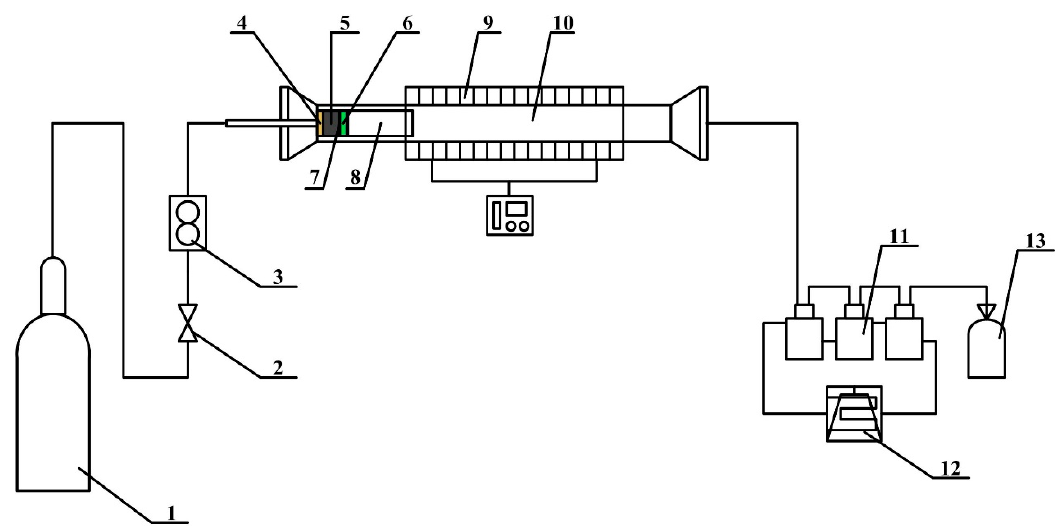
Figure 1. Schematic diagram of the reactor system. 1, nitrogen; 2, regulating valve; 3, gas flowmeter; 4, corn stalk; 5, quartz sand; 6, catalyst; 7, asbestos-free wire gauze; 8, feedstock bin; 9, horizontal tubular furnace; 10, reactor; 11, absorption and filtration devices; 12, cooling pump; 13, air bag.